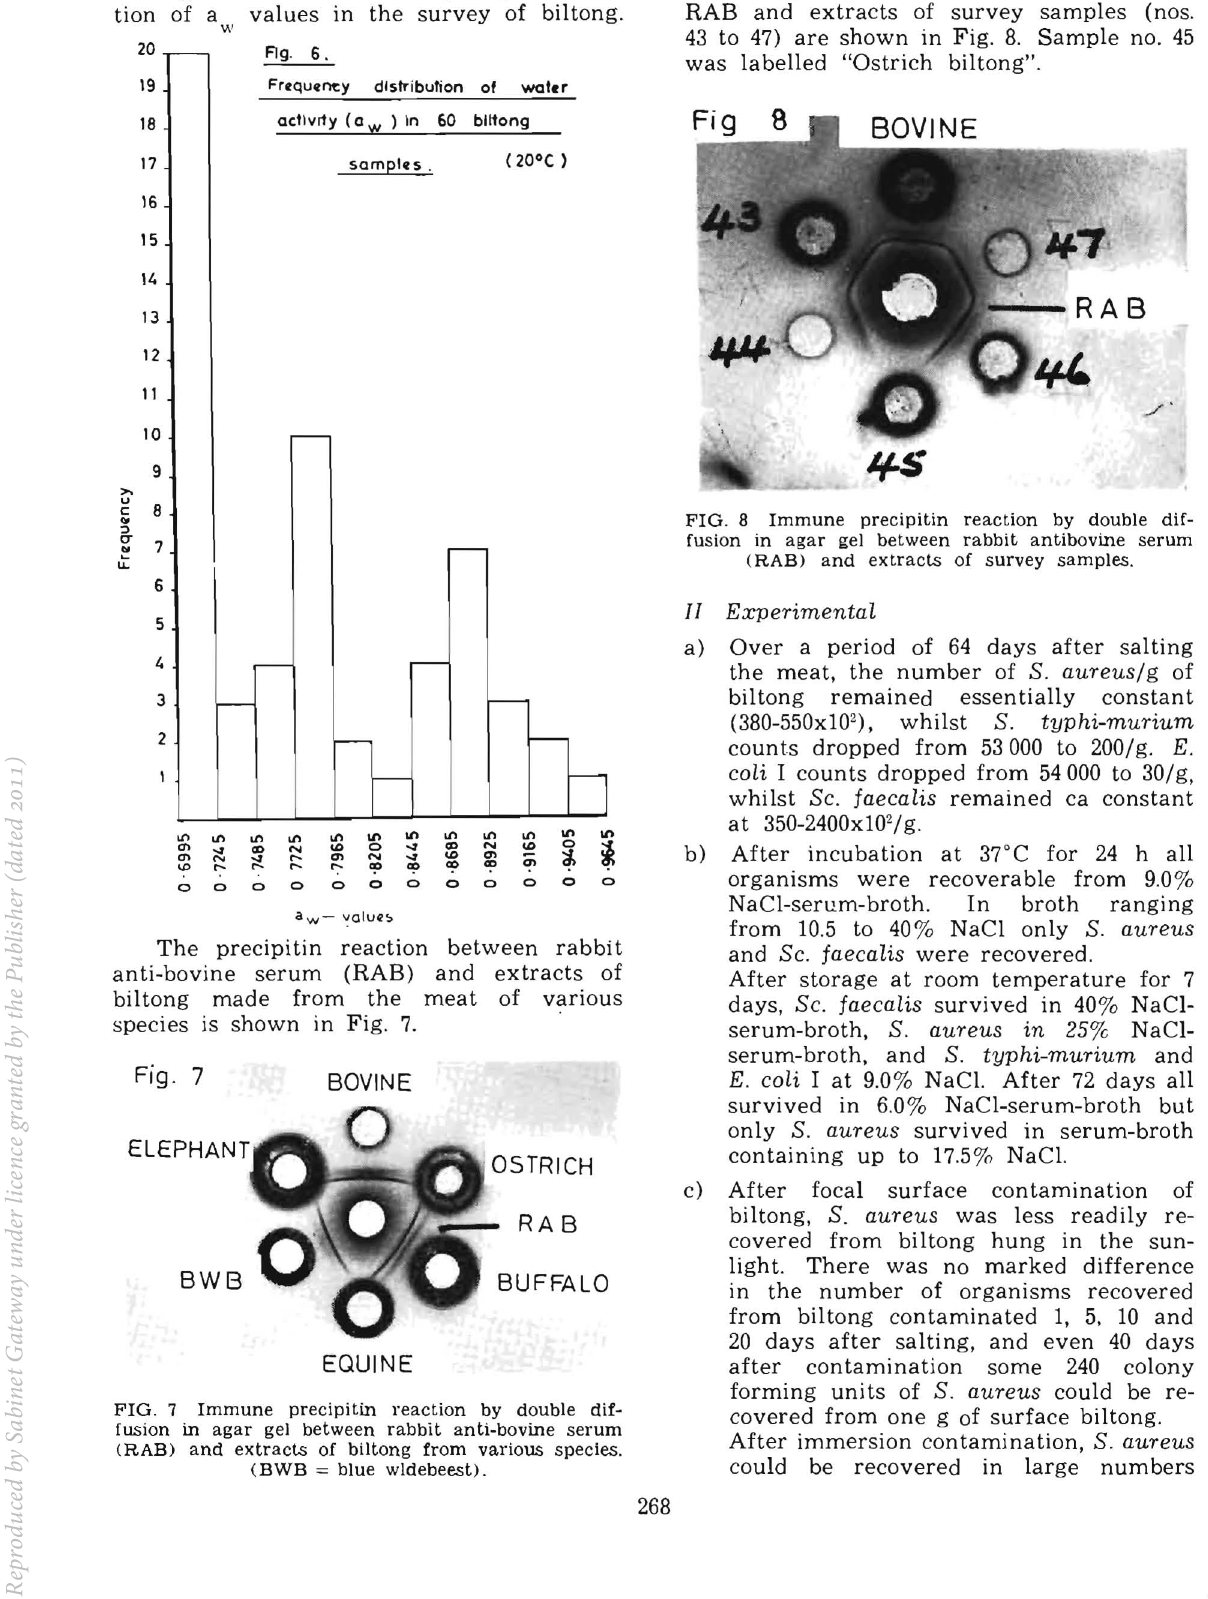
Fig 6 --- Froquent:y distribution 01 wal.r actlvrty (a!!l! ) In 60 blHong samples.